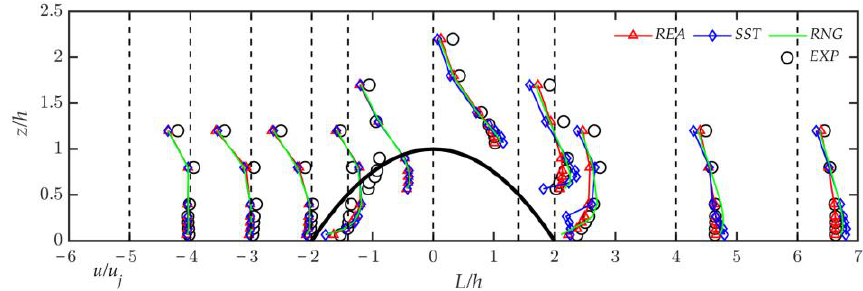
Figure 4. Comparison of mean velocity between different turbulence models and experiments.